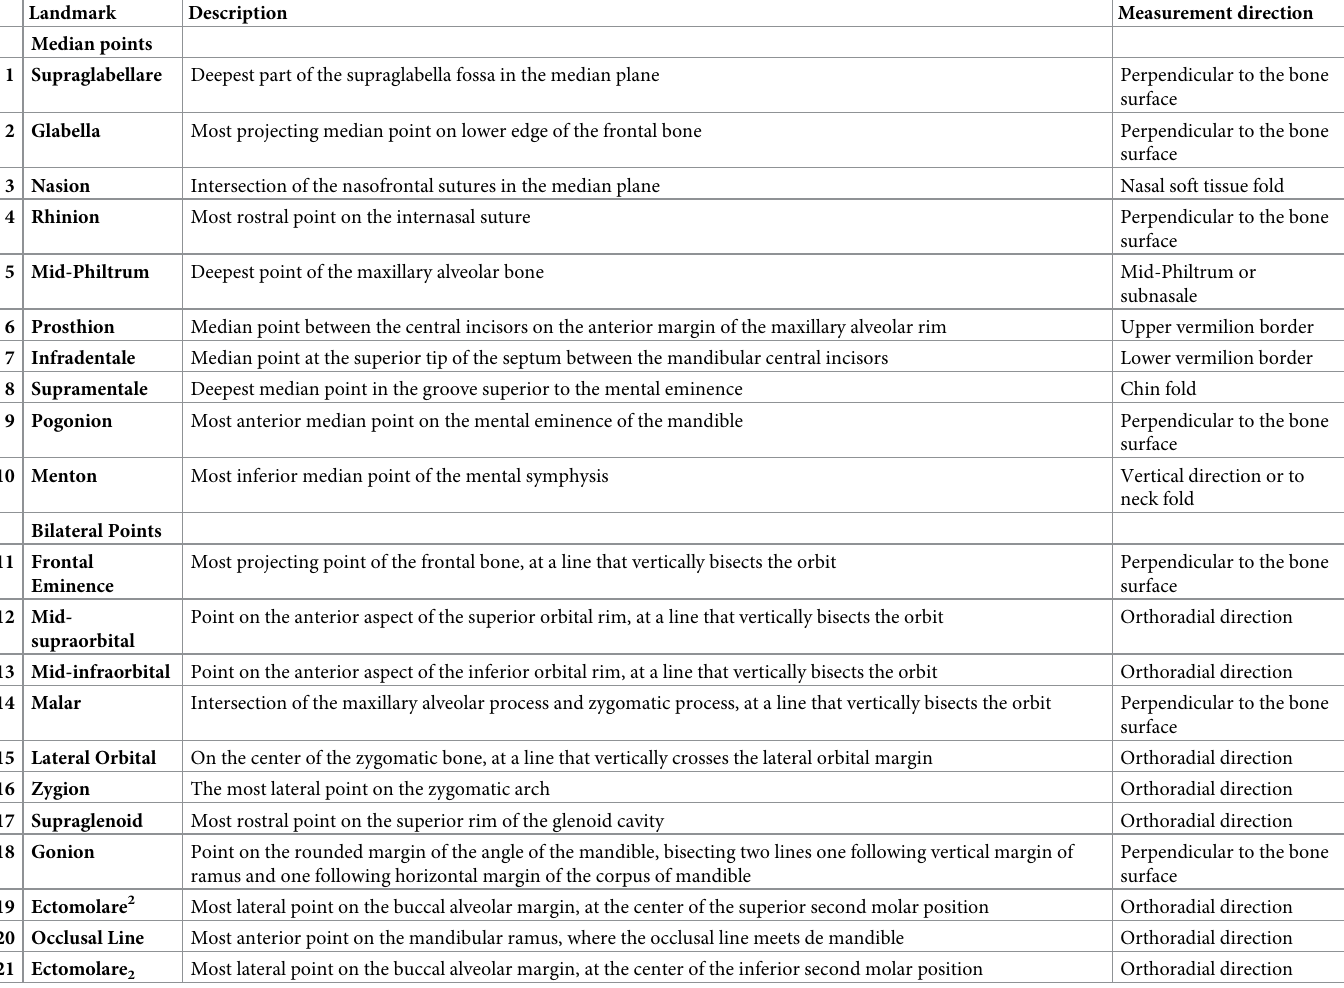
Table 2. Craniometric landmarks, descriptions, and measurement